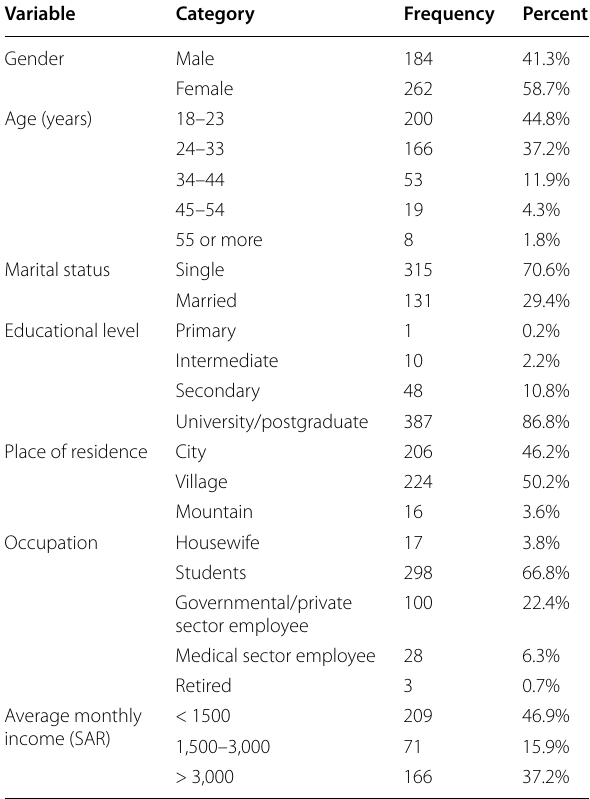
Table 1 Sociodemographic characteristics of the participants ( n